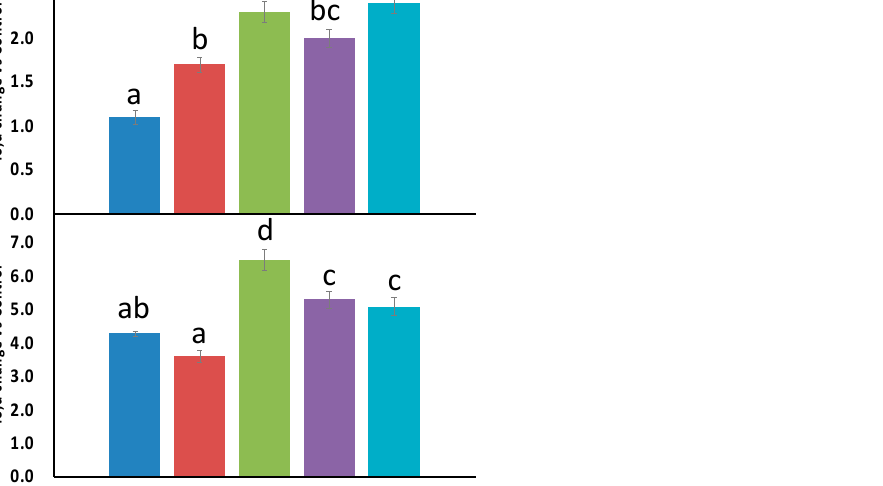
Figure 5. The effect of the 90% ethanol extract of the five most biologically active Streptomyces isolates (Act 2, Act 12, Act 15, Act 19 and Act 21) on cyclooxygenase (COX-2) and lipoxygenase (LOX) activity. Data are represented by the means of at least 3 replicates and error bars represent standard deviations. Different letters above the bars indicate significant differences ( p < 0.05, Tuckey test).